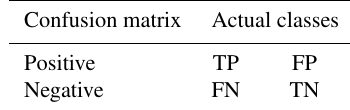
Table 2. The structure of the confusion matrix.